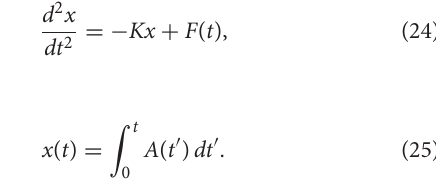
where (cid:127) ( E , B ) is the number of states for a given energy E .